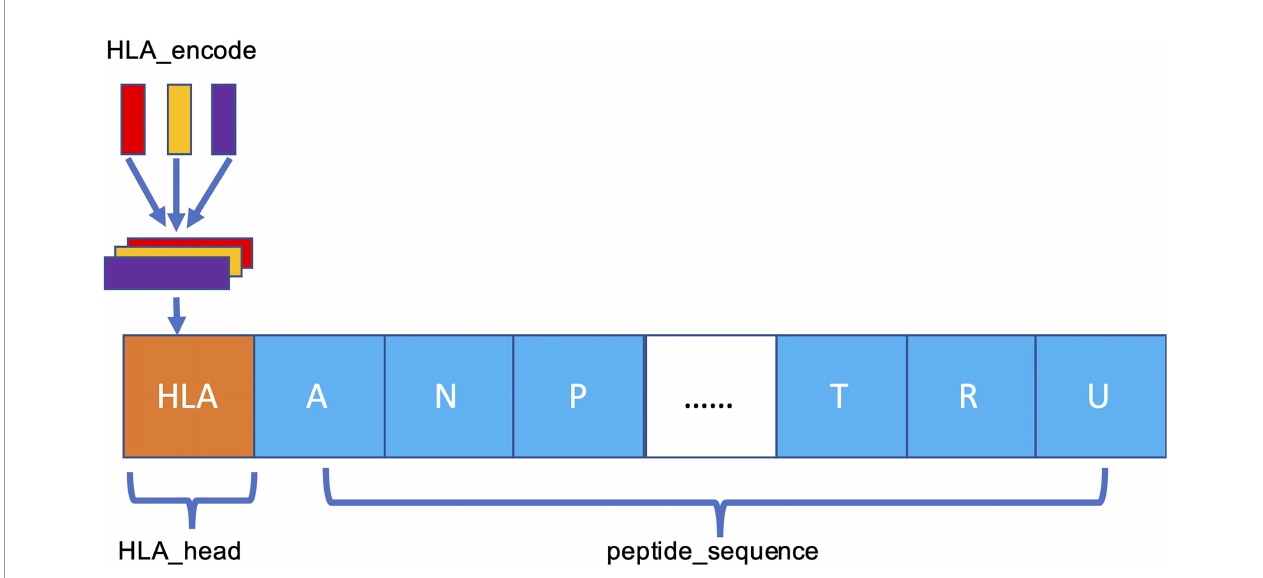
FIGURE 3 | Schema of HLA – peptide fusion encoding. The orange HLA_head is the result generated in Figure 2C . HLA_head is loaded on top of peptide sequence in concatenation mode to form a new constituent sequence containing HLA_head and